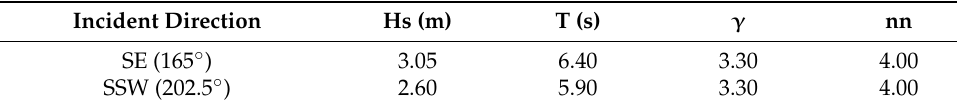
Table 6. Deepwater wave parameters—JONSWAP spectrum